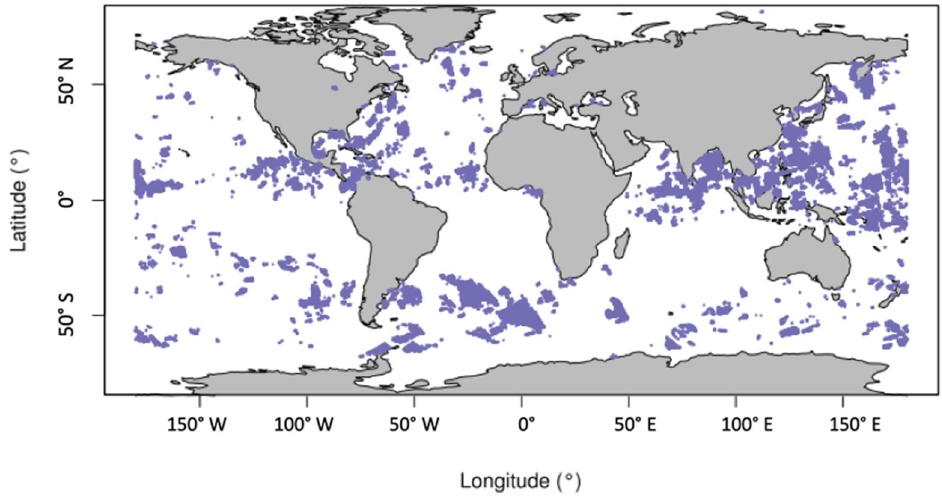
Figure 14. Distribution of cloud pixels used to produce the observation density distribution in Figure 15.